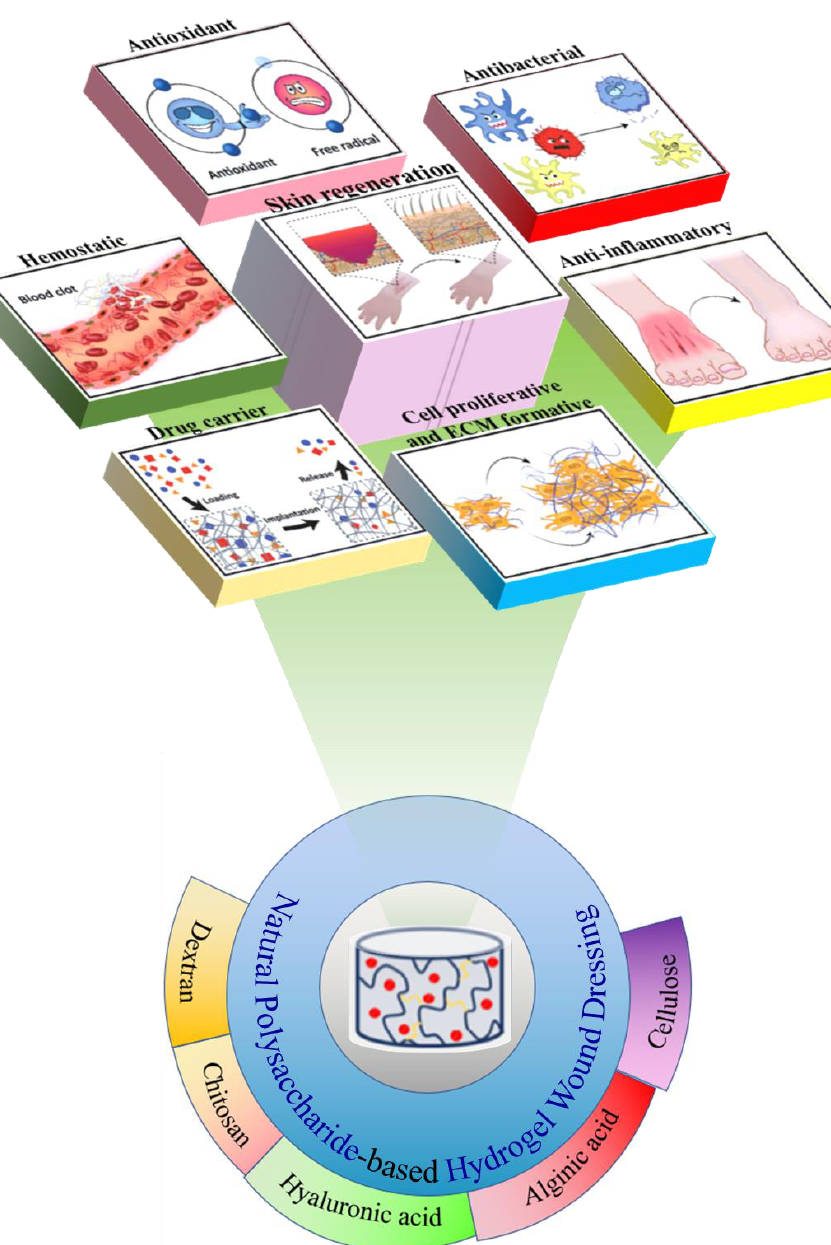
Figure 1. Hyphenate -proliferation and formation of polysaccharide-based hydrogel wound dressing. Reprinted with permission from Ref. [26]. Copyright 2021, copyright with permission from Ahmadian and Correia and